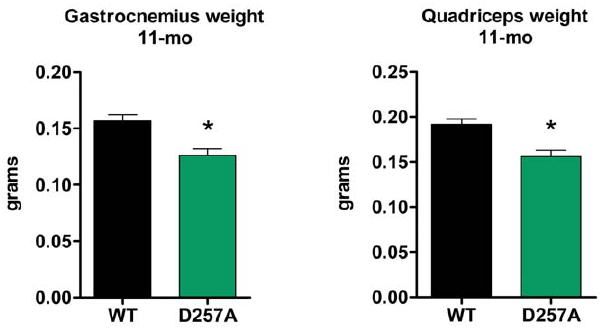
Figure 1. D257A mice display significant skeletal muscle loss. At 11 mo of age, gastrocnemius (n=22 per group, *p , 0.001) and quadriceps (n=22 per group, *p , 0.001) mean muscle mass in D257A mice is significantly decreased compared to age-matched WT. Error bars represent SEM.